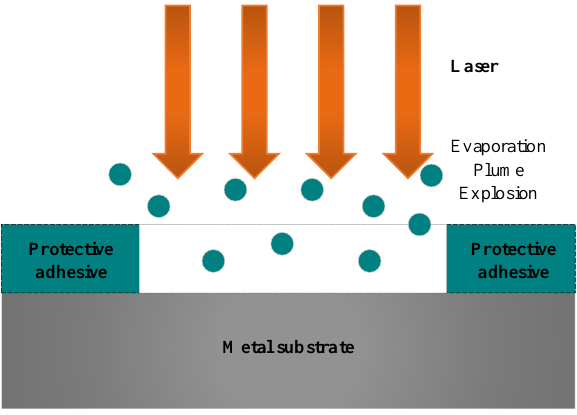
Figure 6. Mechanism diagram of laser engraving.